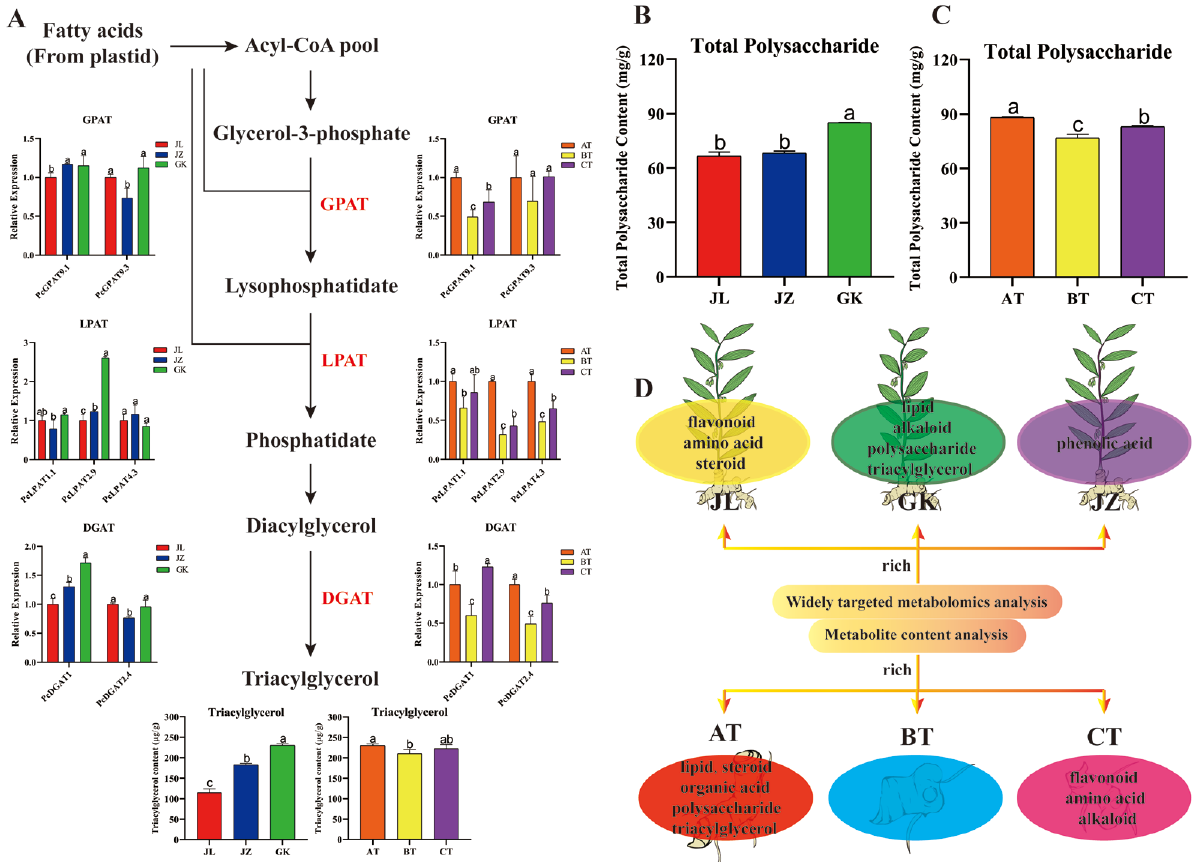
Figure 6. Analysis of triacylglycerol synthesis pathways and metabolic components in P. cyrtonema . ( A ) Triacylglycerol content and triacylglycerol biosynthesis pathway of different germplasms and different age sections, ( B ) Total polysaccharide content of different germplasms , ( C ) Total polysaccharide content of different age sections, ( D ) Enrichment map of the main nutritional and medicinal components of P. cyrtonema in different germplasms and different age sections . The lowercase letters (a, b, and c) indicate significant difference ( p < 0.05).